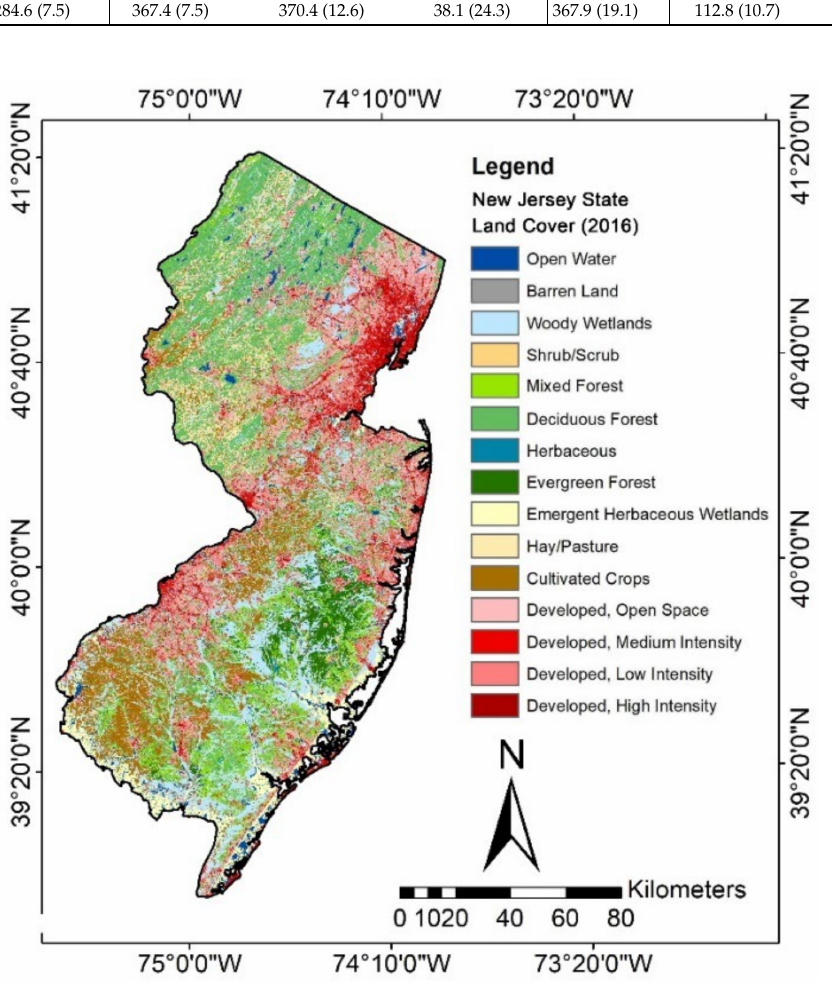
Figure 3. Land cover map of New Jersey (USA) for 2016 (Latitude: 38 ◦ 56 (cid:48) N to 41 ◦ 21 (cid:48) N; Longitude: 73 ◦ 54 (cid:48) W to 75 ◦ 34 (cid:48) W) (based on data from MRLC